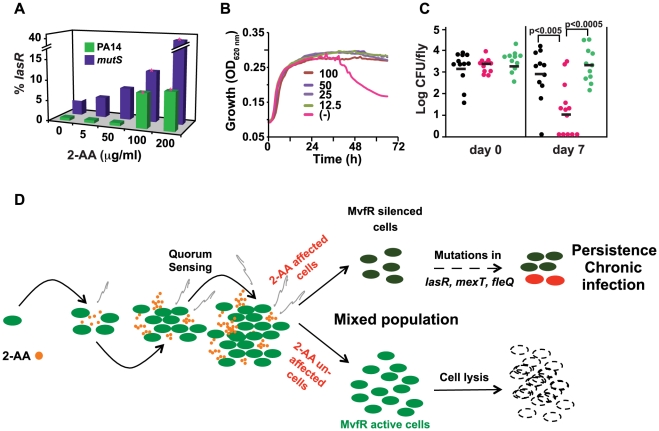
2-AA promotes phenotypes associated with pathogenic bacteria at chronic infection sites.(A) 2-AA promotes increased accumulation of lasR mutations in PA14 and mutS cells in a concentration-dependent manner. Data are averages of two independent experiments, performed in triplicate. Significance of difference in number of lasR mutants was calculated using Student's t-test, assuming equal variance. Asterisks represent significant differences relative to the untreated control group. For both PA14 and mutS mutant cells, lasR mutant accumulation was significantly increased with 100 µg/ml and 200 µg/ml 2-AA (p's = 0.02 and 0.0001 for PA14, and p's = 0.05 and 0.01 for mutS, respectively). (B) 2-AA promotes prolonged stationary phase growth. Untreated PA14 cells began to lyse by 40 h, whereas PA14 cells treated with 2-AA at all tested concentrations did not. (C) 2-AA promotes persistent infection in flies. Bacterial CFUs per fly were assessed at 7 d post-P. aeruginosa feeding (6–9 flies per time point). Significant differences in CFUs after 7 d were seen for pqsA (pink) versus PA14 (black) or pqsB::C (green); Student's t-test p values are indicated in the figure. The data presented were combined from two independent experiments. (D) A model for 2-AA function. As the volatile (squiggly grey lines) 2-AA accumulates overtime in a microenvironment (i.e. biofilms, wounds or CF lungs) it creates a heterogeneous population of cells that consists of WT and physiologically and genetically different cells. The unaltered WT cells undergo lysis. On the other hand, the subpopulation of cells with silenced MvfR can continue to accumulate mutations that are beneficial for adaption to chronic infection.